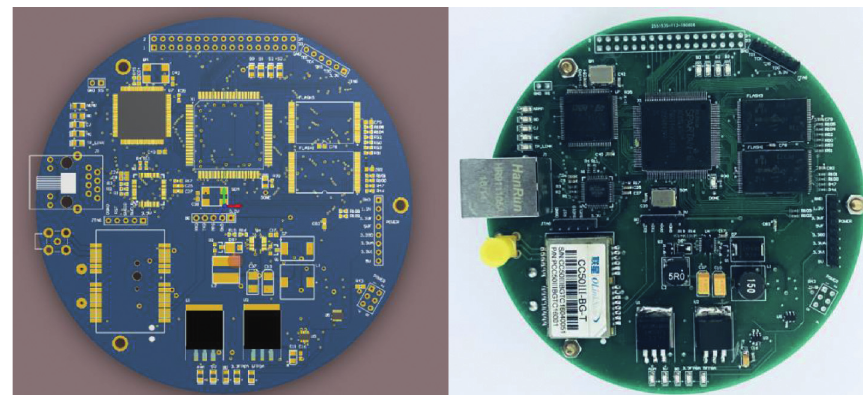
Figure 9: Photos of the core circuit board of the wireless vibration sensor node.